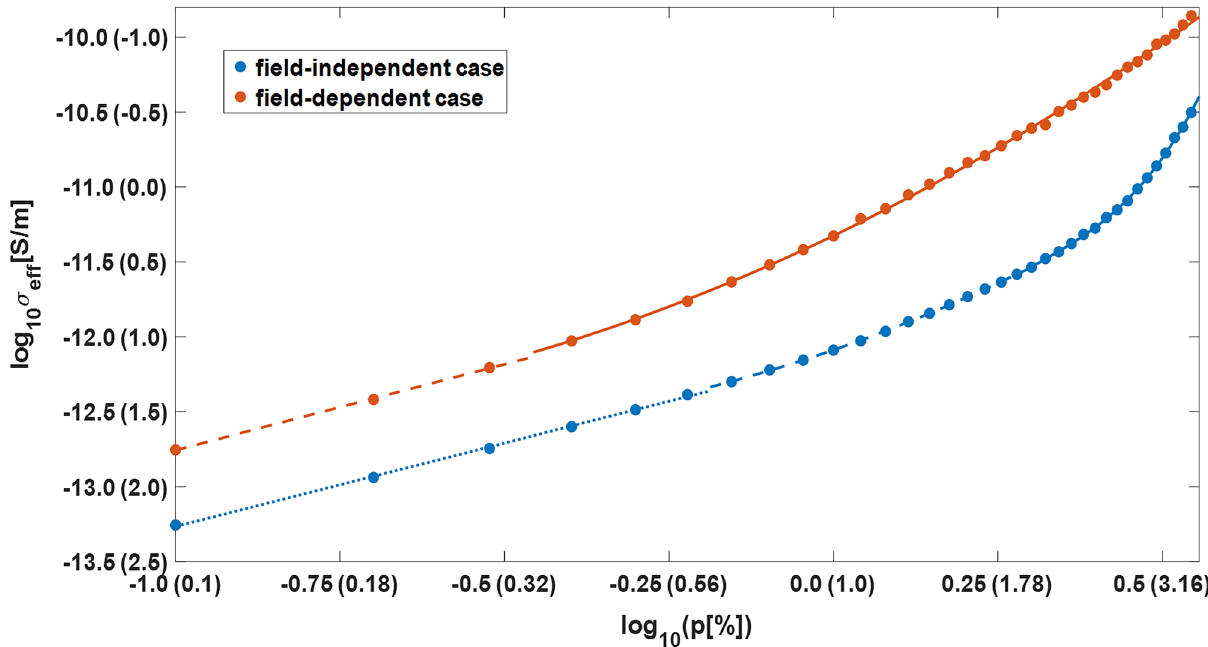
Figure 6. Dependence curves (16) of effective (relay) conductivity σ eff on the filling factor p for field-dependent and field-independent cases shown in bi-logarithmic axes with a model link lifetime τ l assumed to be 1 s (see paragraph “Model link prototypes”). On horizontal and vertical axes additional values shown in the parentheses stand for filling factors p expressed in percents and decimal logarithms of the corresponding electric field ε 0 /σ eff expressed in seconds (with permittivity of free space ε 0 rounded to 10 − 11 F/m), relaxation times τ =